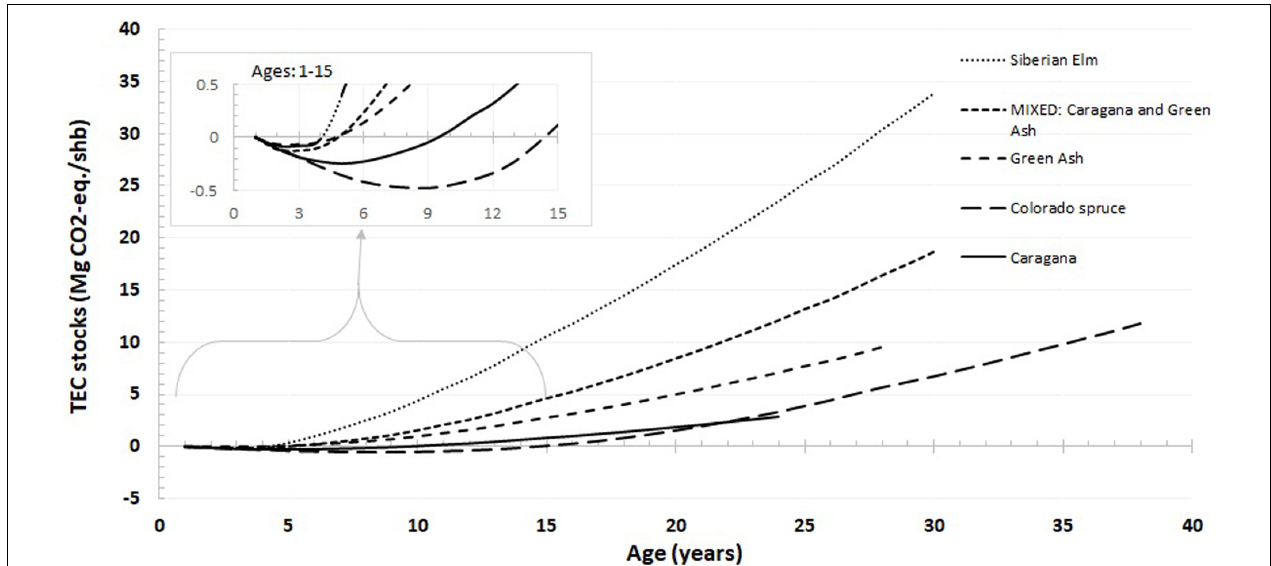
FIGURE 5 | Estimated Total Ecosystem Carbon (TEC) accumulation through different shelterbelts (of different age) near Indian Head, SK, Canada, using adjusted values from the representative estimates of Cluster BLK 3 (Amichev et al.,